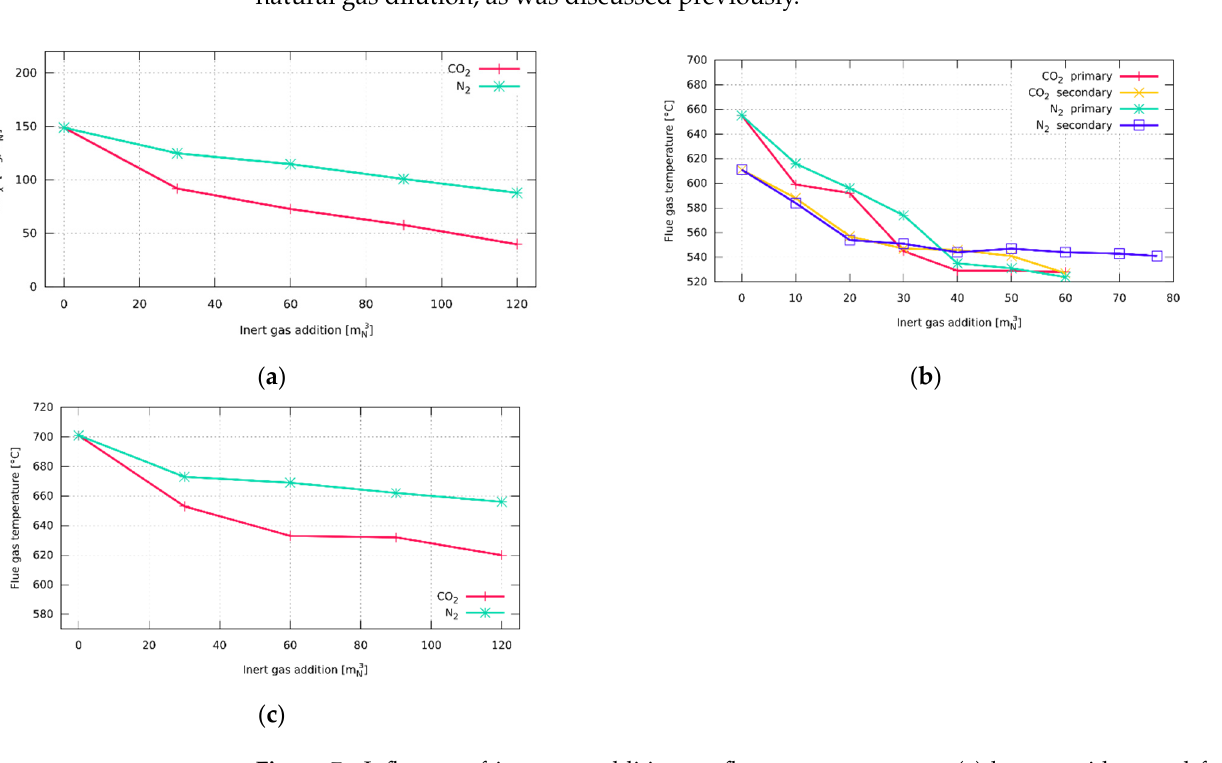
Figure 7. Influence of inert gas addition on flue gas temperature: ( a ) burner with staged fuel distribution—Burner A; ( b ) burner with staged air distribution—Burner B; ( c ) low-calorific burner— Burner C. Table 8. Experimental matrix—TEST B, C—Burners A, B ( • indicates that the test was carried